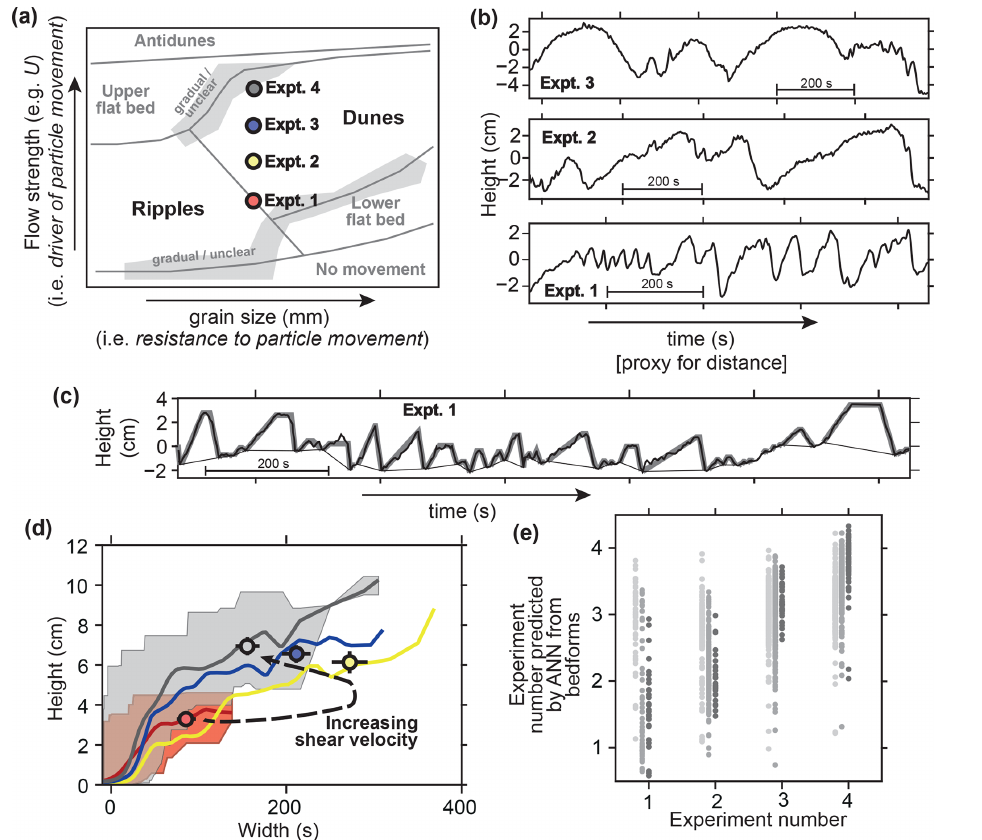
Figure 1. (a) Illustrative bedform stability “phase diagram” for unidirectional fluvial (i.e. river) bedforms, synthesized from multiple sources (Ohata et al., 2017; Lewis and McConchie, 1994; Southard and Boguchwal, 1990). Main types considered here (i.e. ripples and dunes) are highlighted. Experiments (Expts.) 1–4 are positioned indicatively. (b) Distance–height profiles (strictly speaking time series) like those given unannotated to participants, i.e. one each from Expts. 1–3, all scaled to the same dimensions. Horizontal axis is time because in the flume tank a stationary sensor recorded height as bedforms passed beneath it. (c) Example of how height ( H ) and width ( W ) are determined. Measured heights (thick black line) are processed using the SWT algorithm to identify bedforms, drawing a line beneath them (thin black line), which is then approximated as flat-topped cones (grey lines). SWT parameters as in Hillier (2008). (d) Height–width relationships for the four experiments, with colours as in (a) : lines are sliding means with W (Gaussian weights, width 60s); shaded areas are full ranges for Expts. 1 and 4; and dots are the means ( ± 2 σ ) of the upper quartile of the data when the small bedforms (i.e. H< 0.5cm) are excluded. (e) Comparison of the actual experiment number with out of sample prediction of the experiment number by the ANN using H and W : individual bedforms (light grey) and subsets of five bedforms with (grey) and excluding (dark grey) small bedforms.